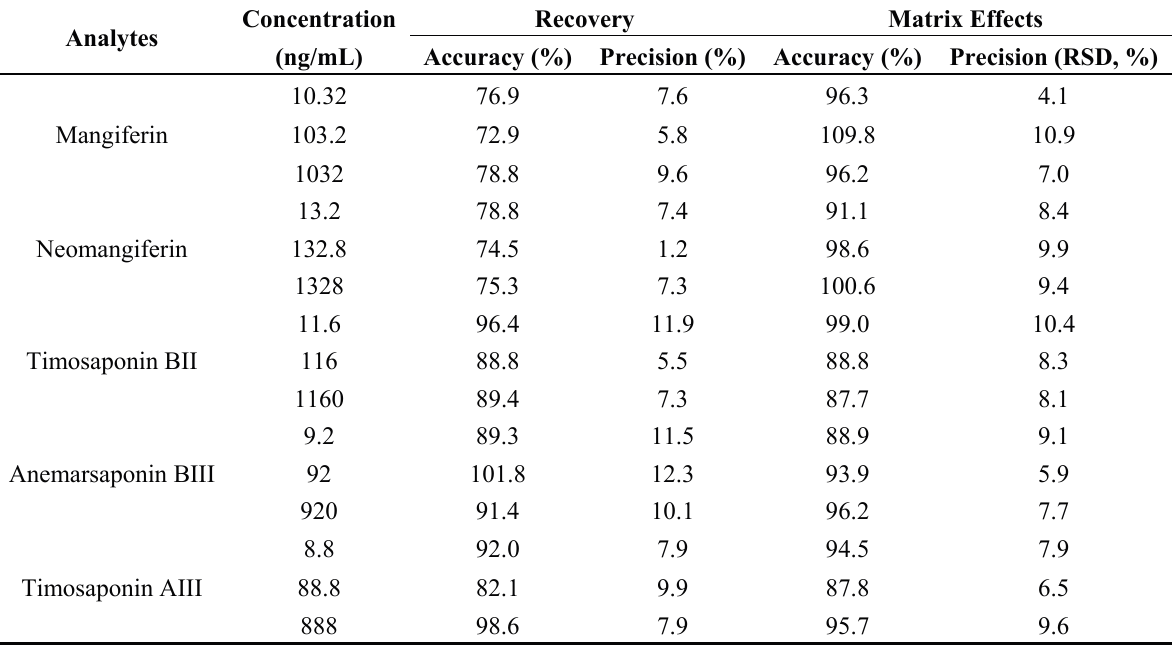
Table 2. Recovery and matrix effects for five analytes in rat plasma (n = 5). Analytes